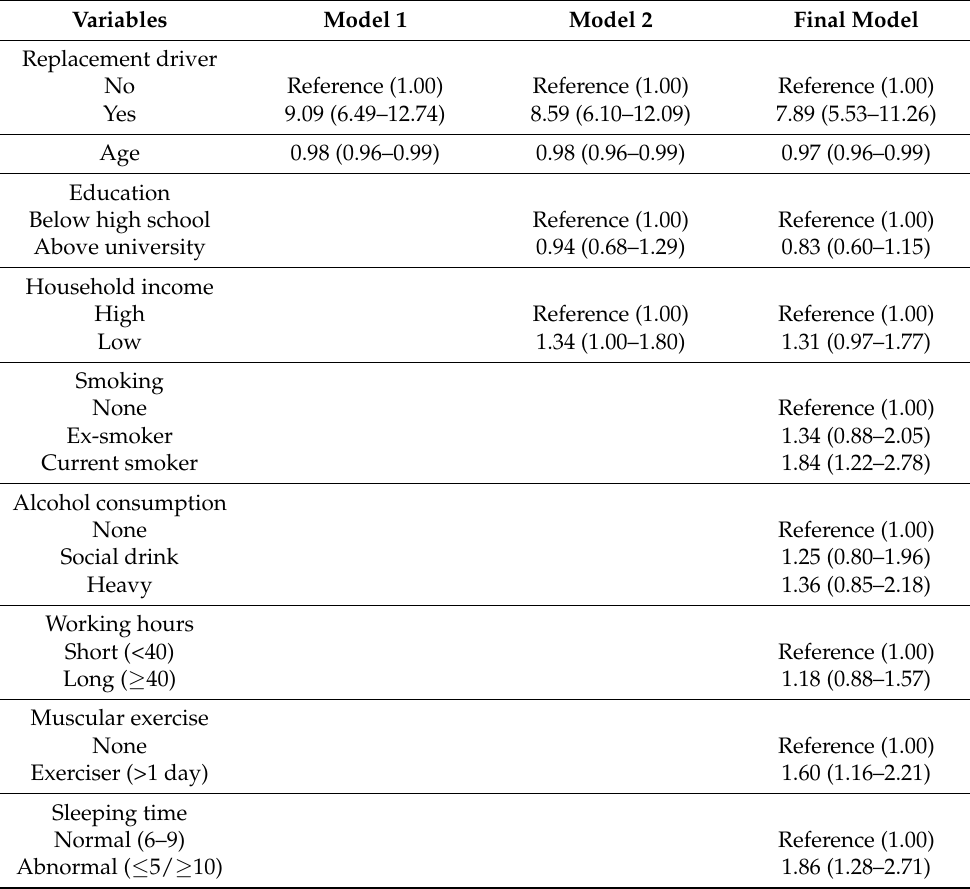
Table 3. Multivariable logistic regression model of depressive